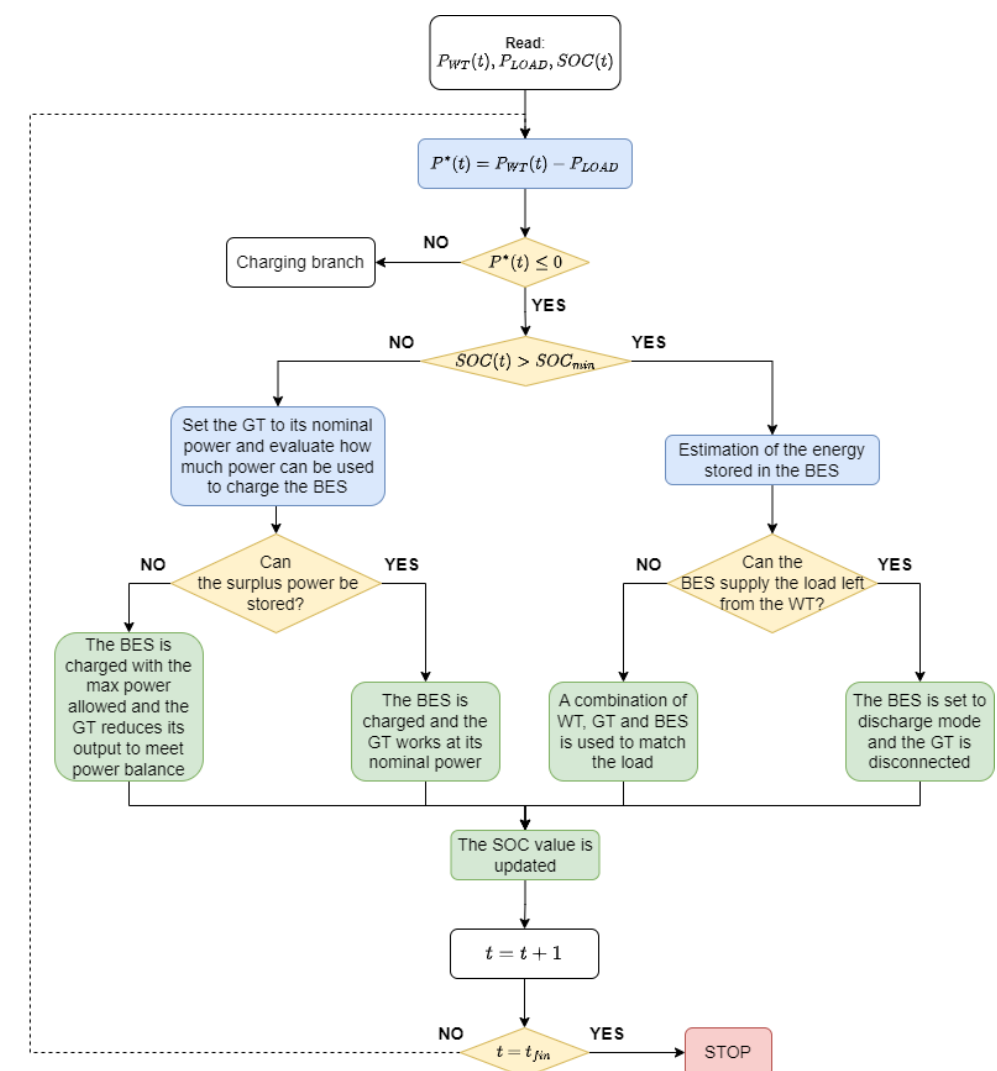
Figure 6. Novel EMS